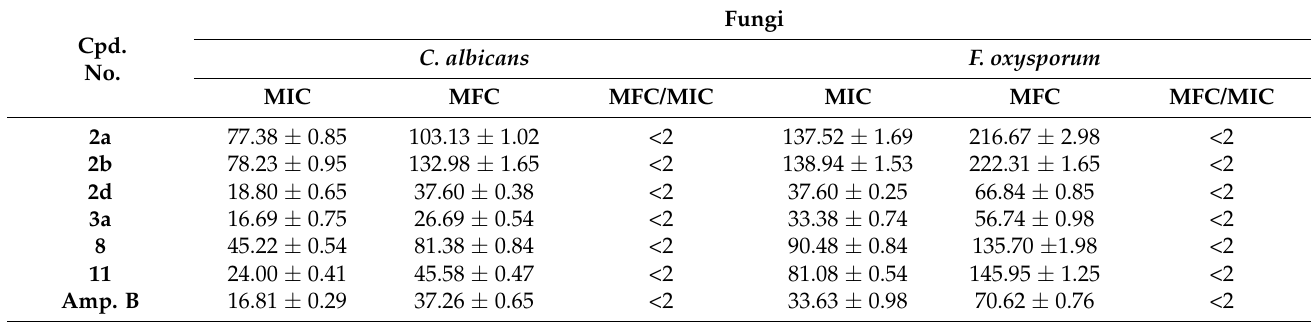
Table 3. In vitro antifungal activity (minimal inhibitory/fungicidal concentration, MIC and MFC), expressed in µ M, of the most promising derivatives against two fungal strains.